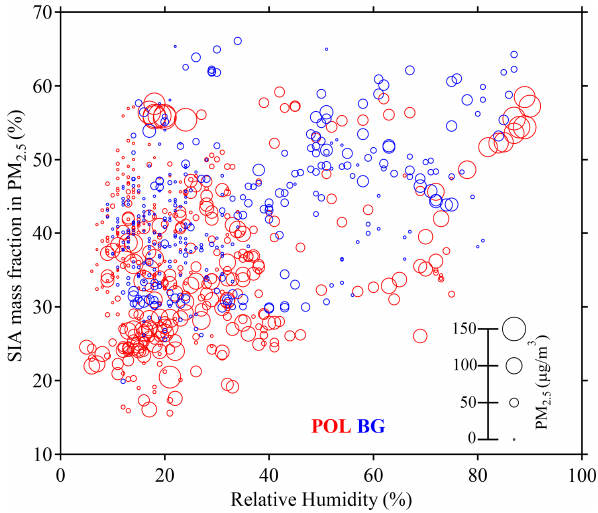
Figure 5. The variation in secondary inorganic aerosol (SIA) mass fraction in PM 2 . 5 as a function of ambient relative humidity during the POL (in red) and BG (in blue) periods. The different circle sizes denote different PM 2 . 5 mass